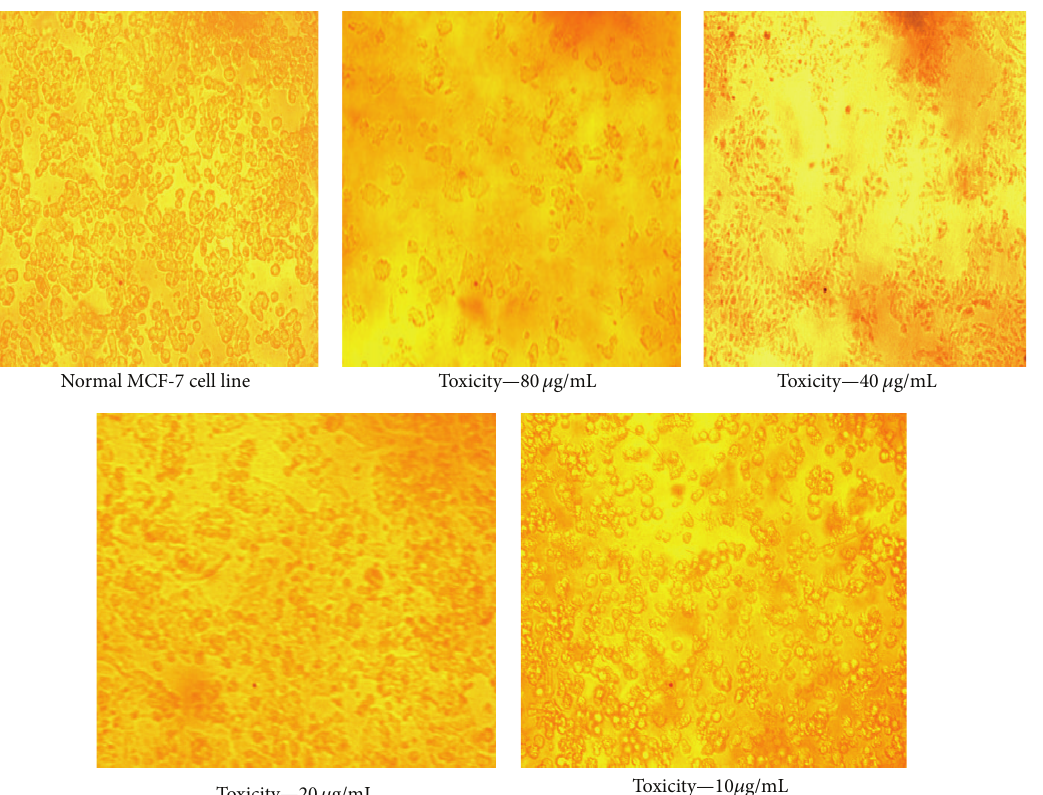
Figure 5: Anticancer effect of flavonoid fraction of Cissus quadrangularis on MCF-7 cell line at different